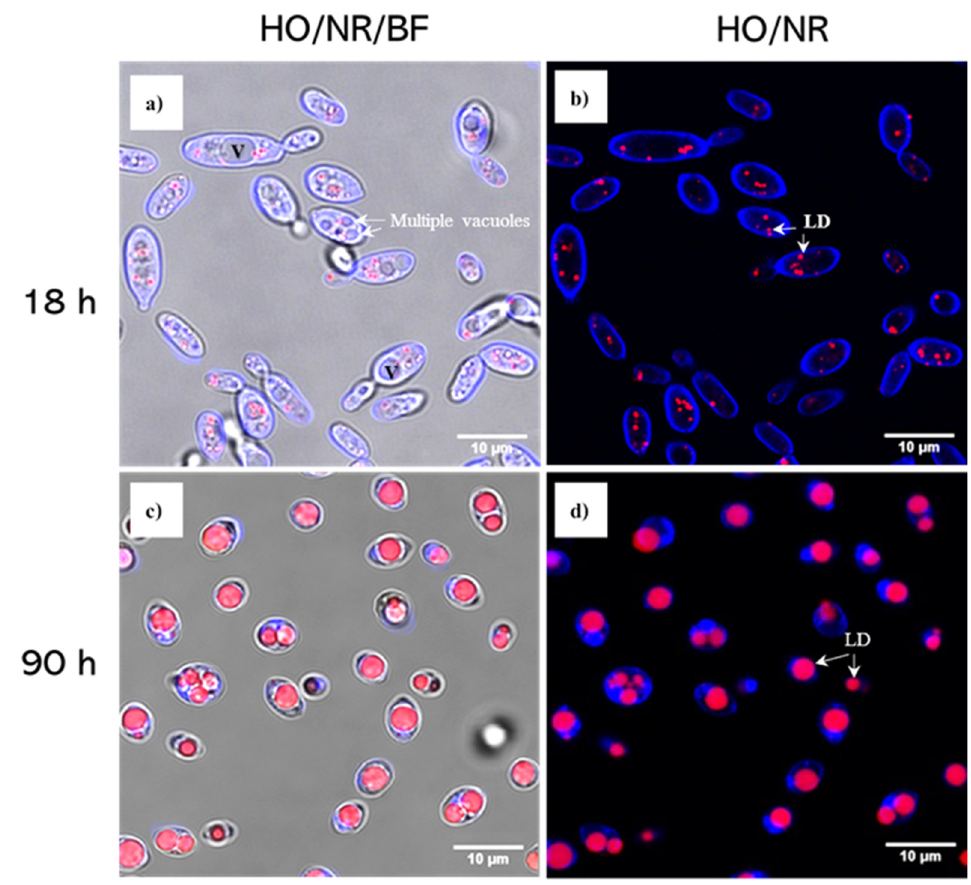
Figure 3. Confocal laser scanning microscopy of C. oleaginosus ATCC 20509 observed after 18 h ( a , b ) and 90 h ( c , d ) of cultivation in WPYEU. Cells (in blue) are stained with Hoechst 34580 (HO), while lipid droplets (LDs) (in red) are stained with Nile red (NR). Vacuoles (V) were observed in bright field (BF).